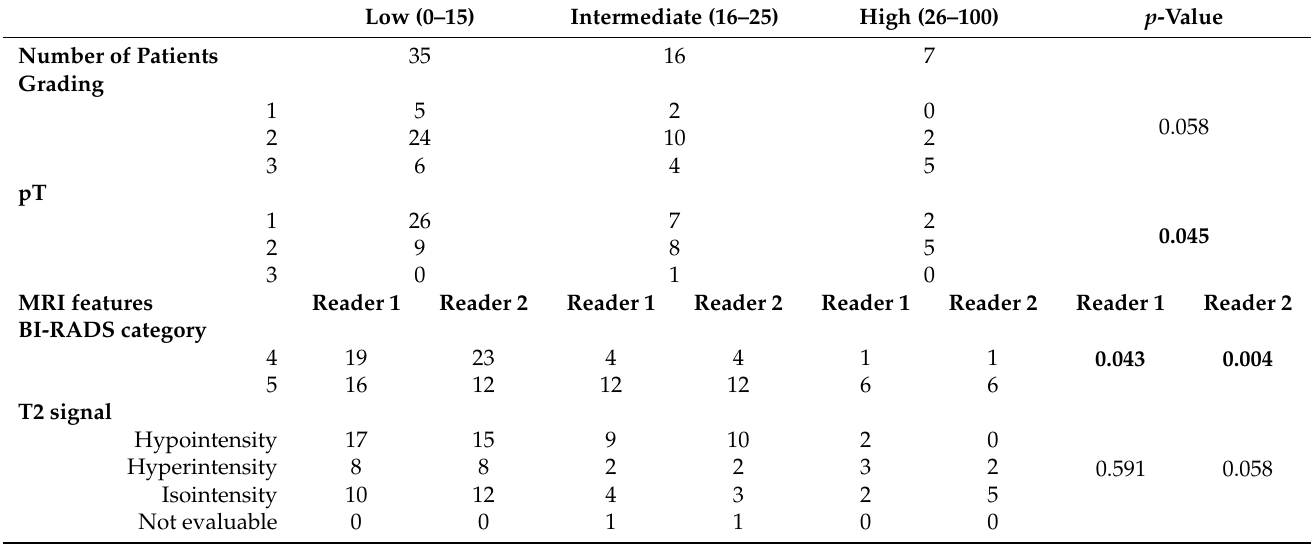
Table 3. Association between pathological and MRI-derived features and ODXRS stratified for level of risk of recurrence. The analysis was performed using the χ 2 test. Statistically significant results are